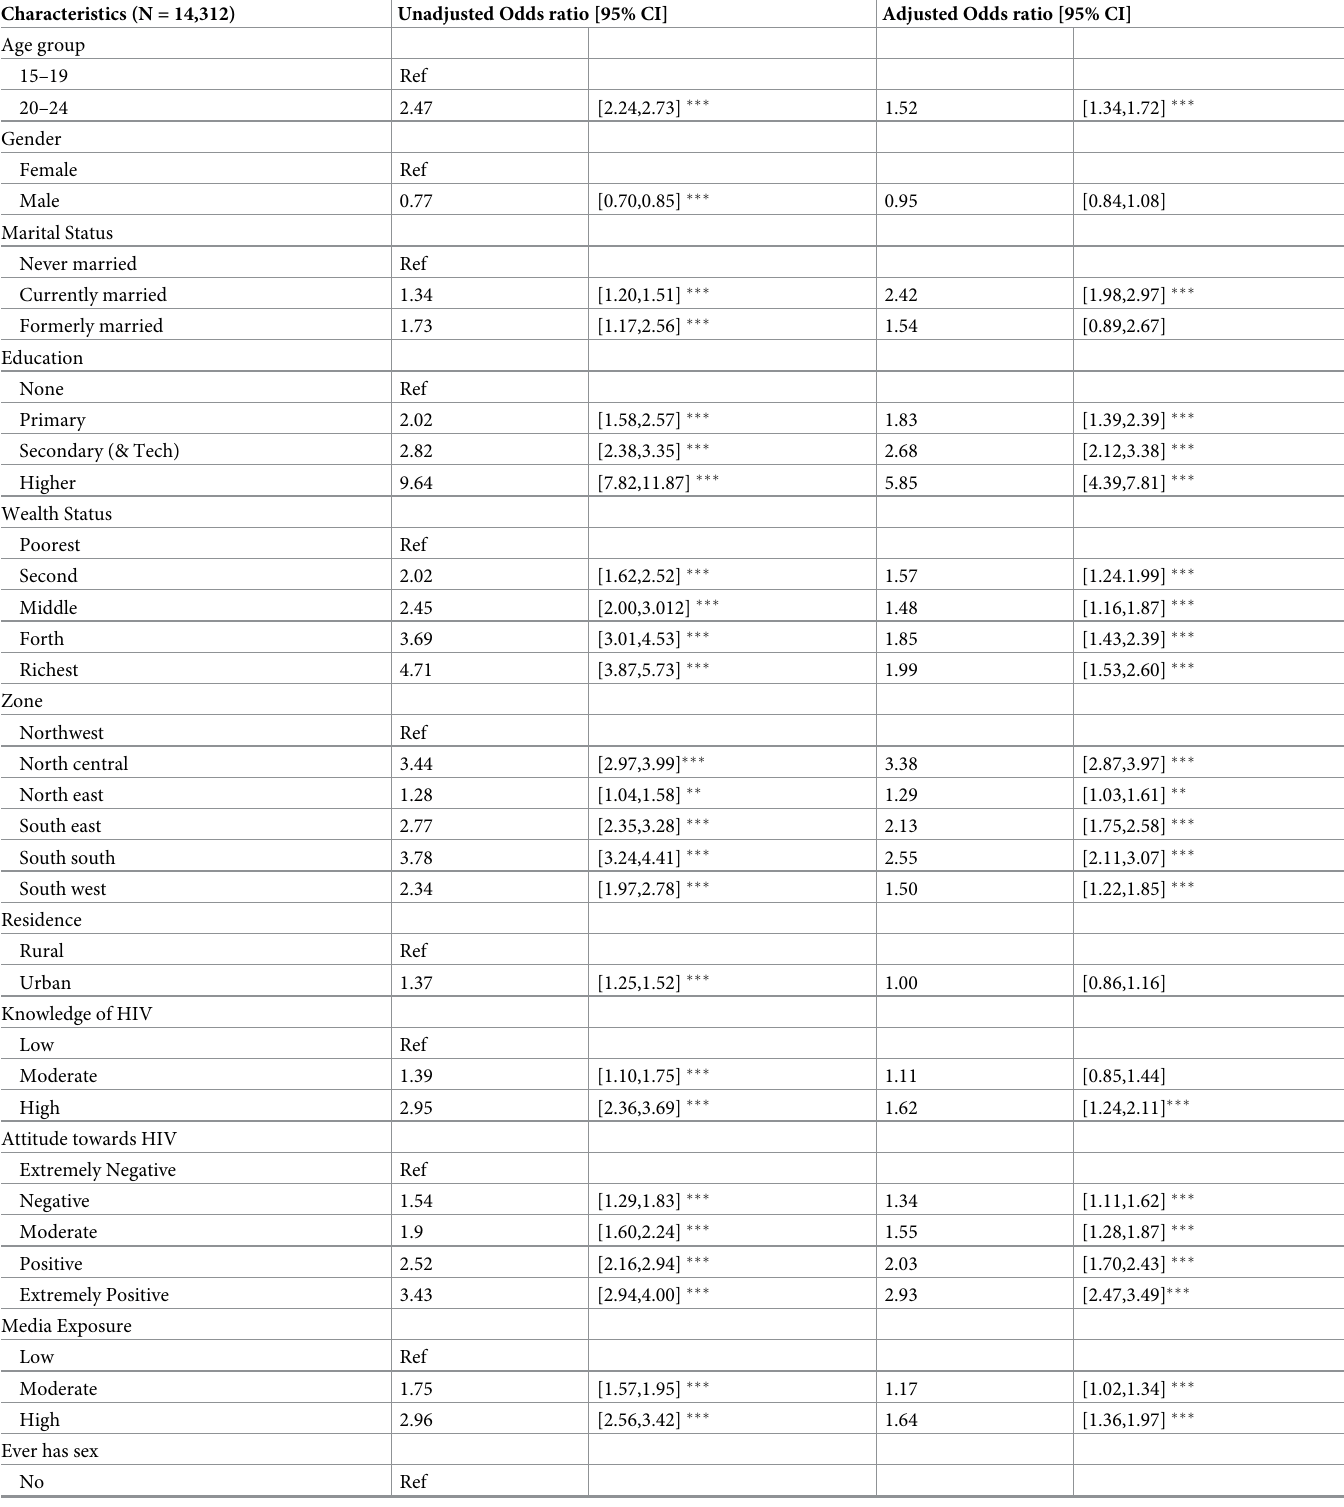
Table 4. Multivariable logistic regression analysis showing predictors of uptake of HIV testing in the respondent’s lifetime. Characteristics (N =